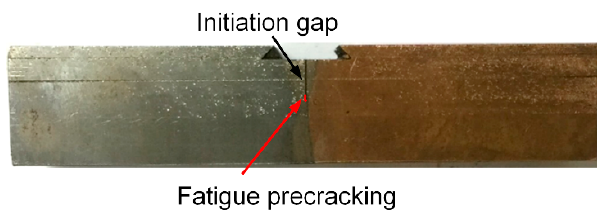
Figure 5. Final specimen of three-point bending.